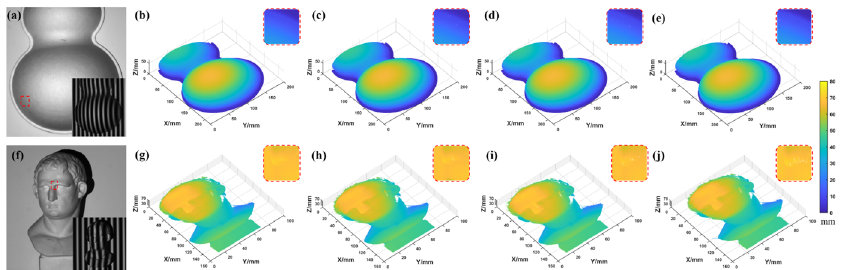
Figure 15. Measurement of a gourd and a statue. ( a , f ) The gourd and statue with their deformed fringe pattern. ( b , g ) The ground truth. ( c , h ) The results of the proposed method. ( d , i ) The results of the traditional TFH method. ( e , j ) The results of the improved DFH method (the small images in the upper right are enlarged images of the selected